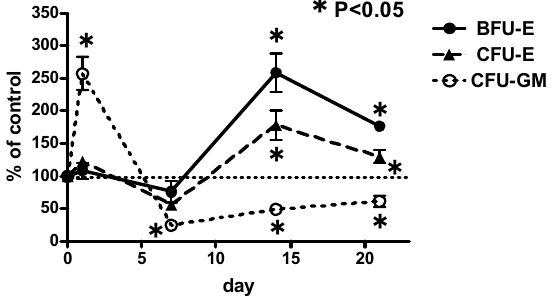
Figure 1. Time course of the numbers of BFU-E, CFU-E and CFU-GM in the spleen after neopterin treatment in mice. Splenic cells were obtained from three mice 1, 7, 14 and 21 days after a single intra- venous injection of 4.0 mg/kg bw neopterin. The changes in the numbers of BFU-E, CFU-E and CFU- GM were determined. Each bar represents the mean ± SD of triplicate experiments. erythroid progenitor cells (BFU-E and CFU-E) and myeloid progenitor cells (CFU-GM) in the spleen after neopterin injection. The number of BFU-E decreased to 76% of the pretreatment level on day 7, followed by